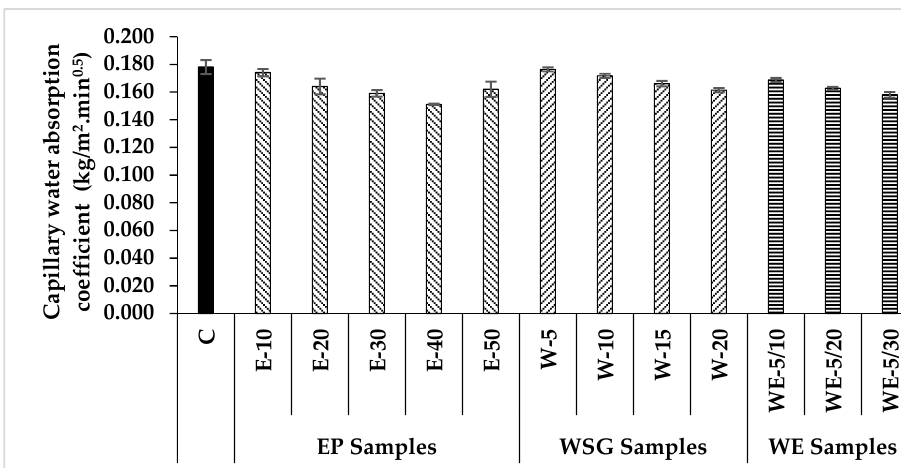
Figure 8. Density results.